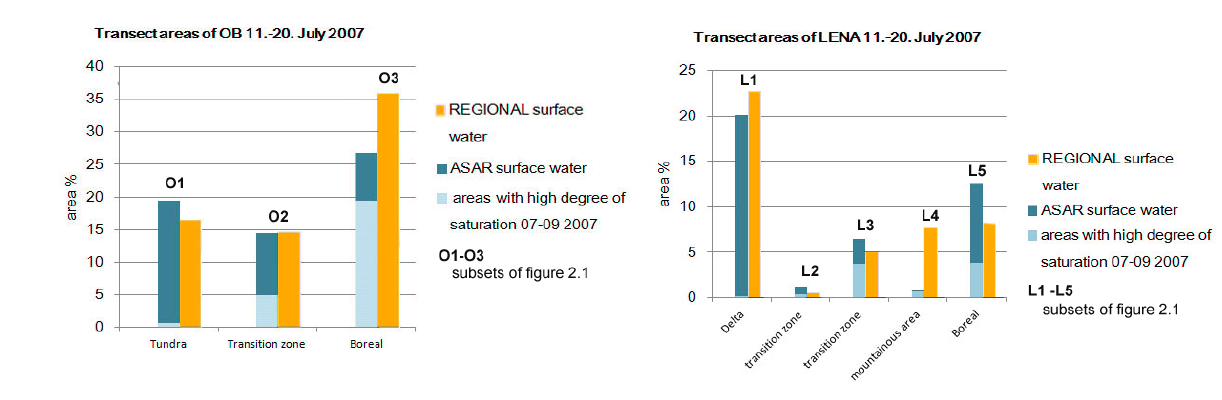
classification ( left ) with carbon content map (( right ); IIASA W